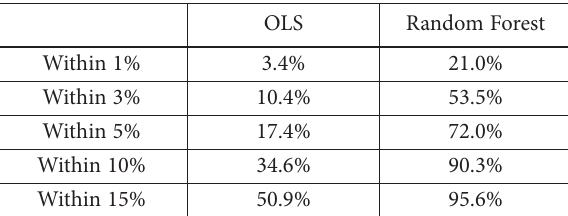
Table 6. Hitting rates (average of 10 trials)